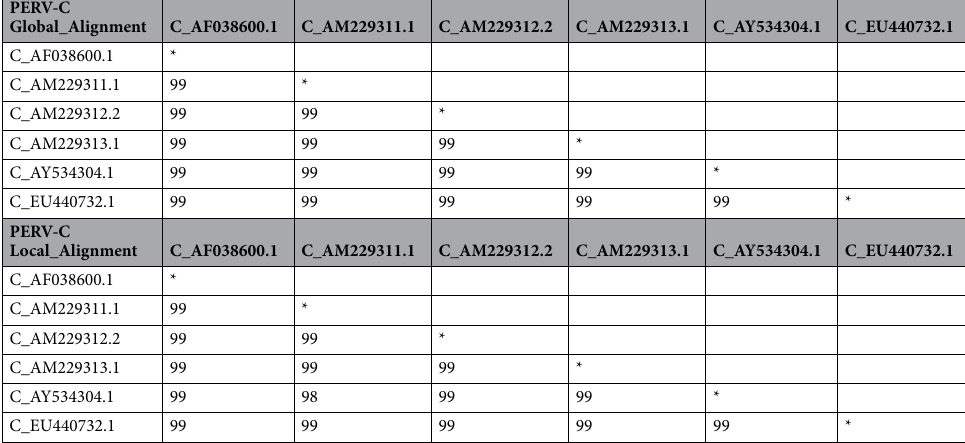
PERV-C vs. A/C Global_